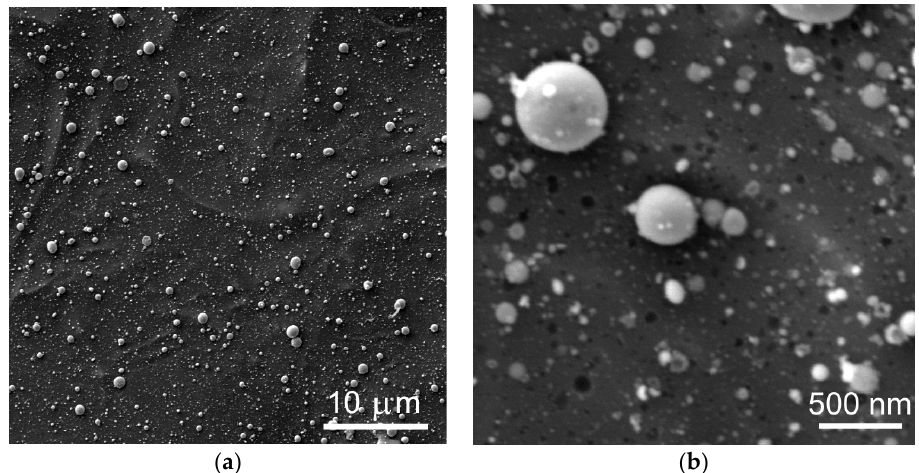
Figure 8. SEM images with ( a ) low and ( b ) higher magnification for the surface of an n + p-Si wafer covered with a 20 nm-thick catalytic a-MoS x /NP-Mo film. covered with a 20 nm-thick catalytic a-MoS x /NP-Mo